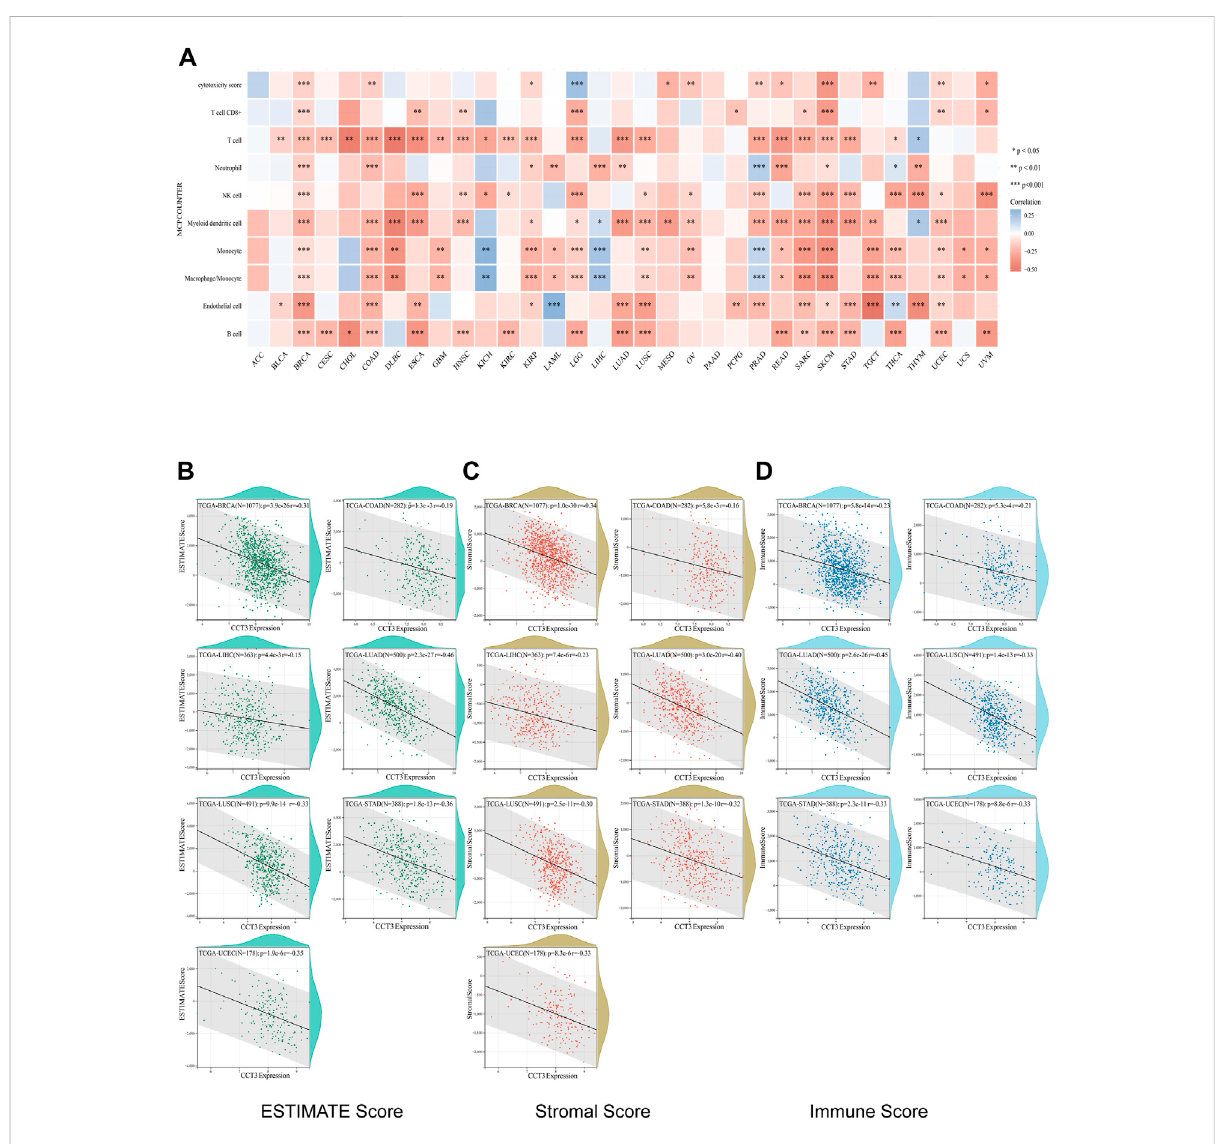
Correlation between CCT3 expression and immune cell in fi ltration. (A) Correlation between CCT3 expression and immune cell in fi ltration was analyzed using theMCP-counter algorithm intheR package “ immunedeconv ” . (B – D) Estimate Immune-in fi ltration score in 8tumors (BRCA,CHOL, COAD, LIHC, LUAD, LUSC, STAD and UCEC) based on CCT3 expression using the R package ‘ ESTIMATE ’